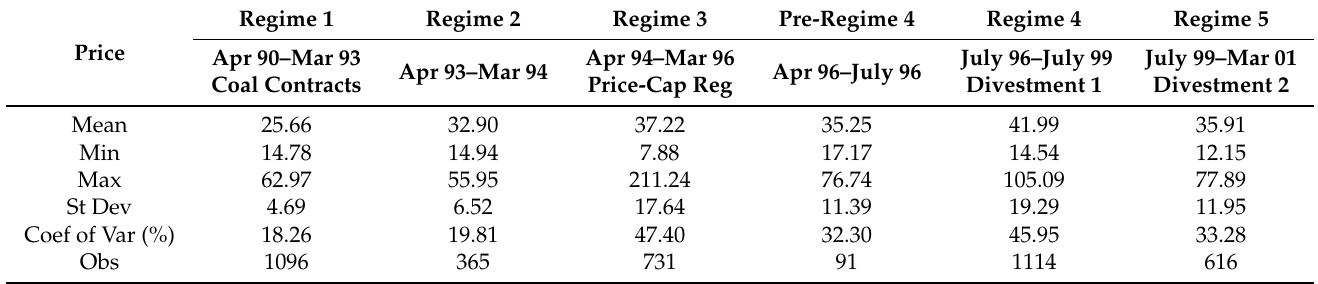
Table 1. Summary statistics of SMP of the peak-demand period during 1 April 1990–26 March